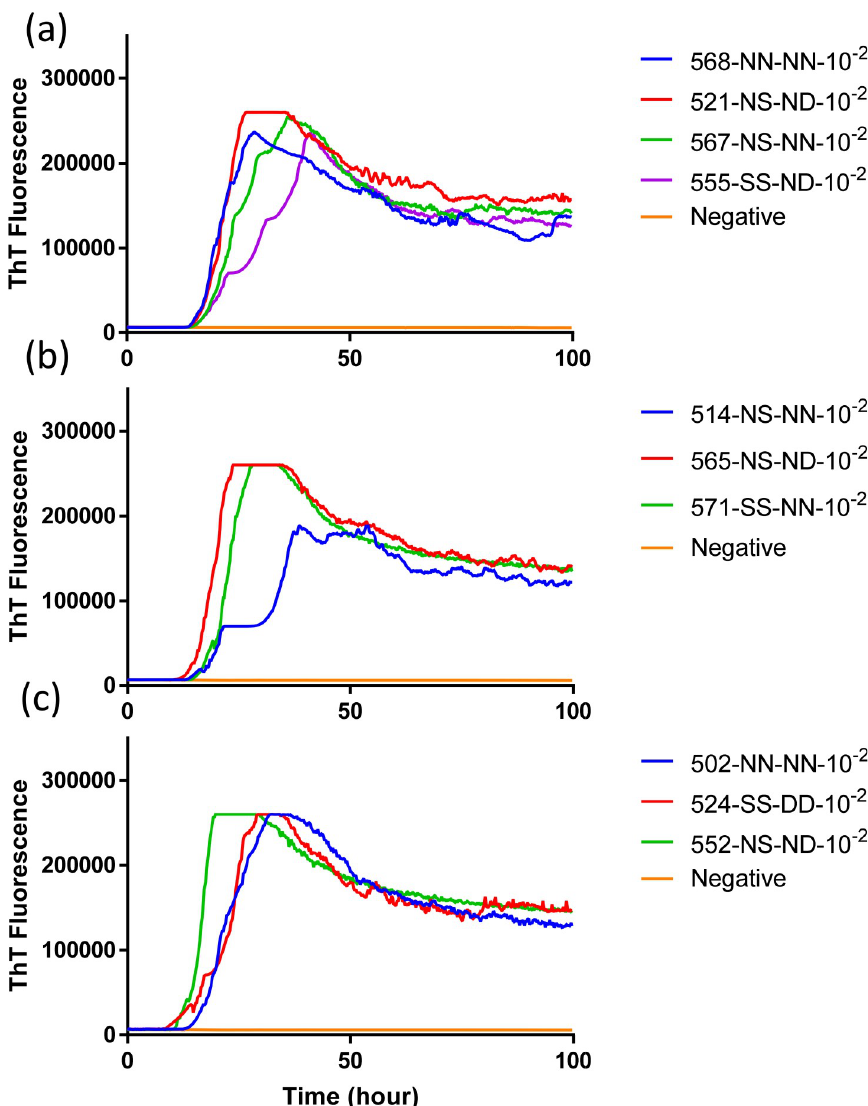
Fig 9. Comparison of seeding activity of RT-QuIC reactions with human rPrP which contain brain seeds from reindeer inoculated with brains of infectious WTD (a), elk (b) or mule deer (c). This shows RT-QuIC reactions seeded with 10 − 2 dilution of EIA normalized brains in the presence of 0.002% SDS. Data are presented as mean ThT fluorescence of 4 repeated reactions. Data are presented as mean ThT fluorescence of 4 repeated reactions.